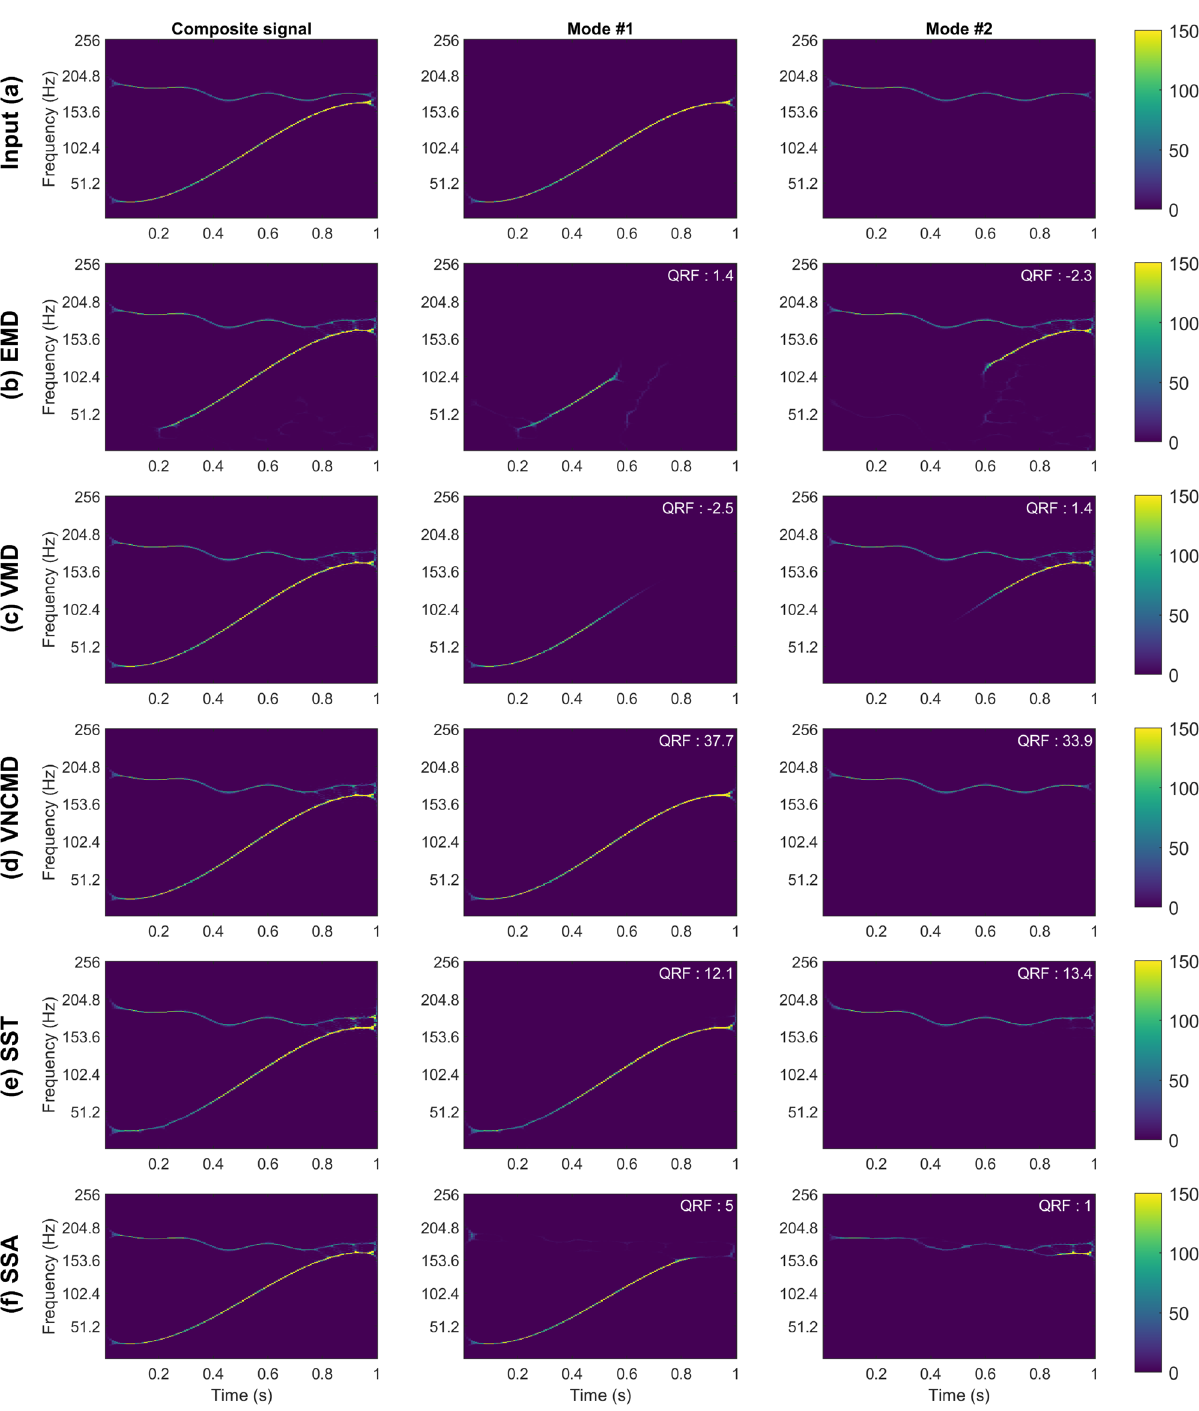
(f). Not only are the extracted components separated from each other in the frequency domain but the relevant component (shown in orange) is narrow-band and ideally centered around the desired frequency range of 8–12 Hz. The superiority of the SSA method is further confirmed by examining the plot in (g) that shows the spectra